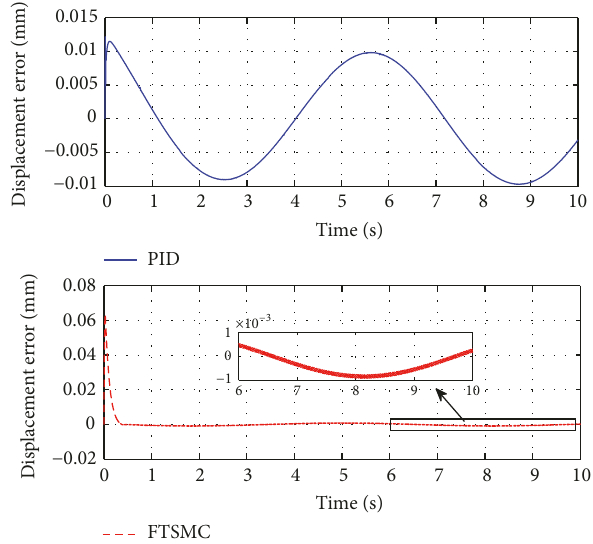
Figure 3: The response curves for displacement error for tracking a sinusoid